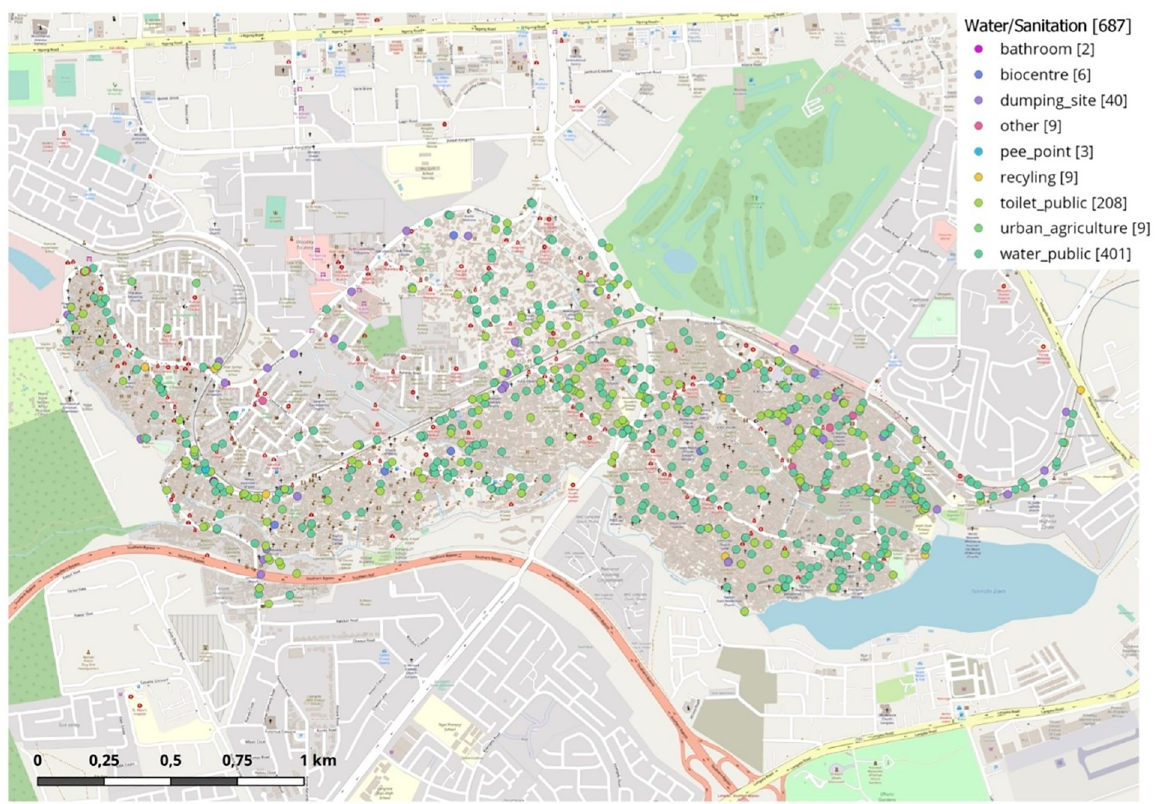
Fig 3. Categories of water and sanitation facilities in the slum—Own